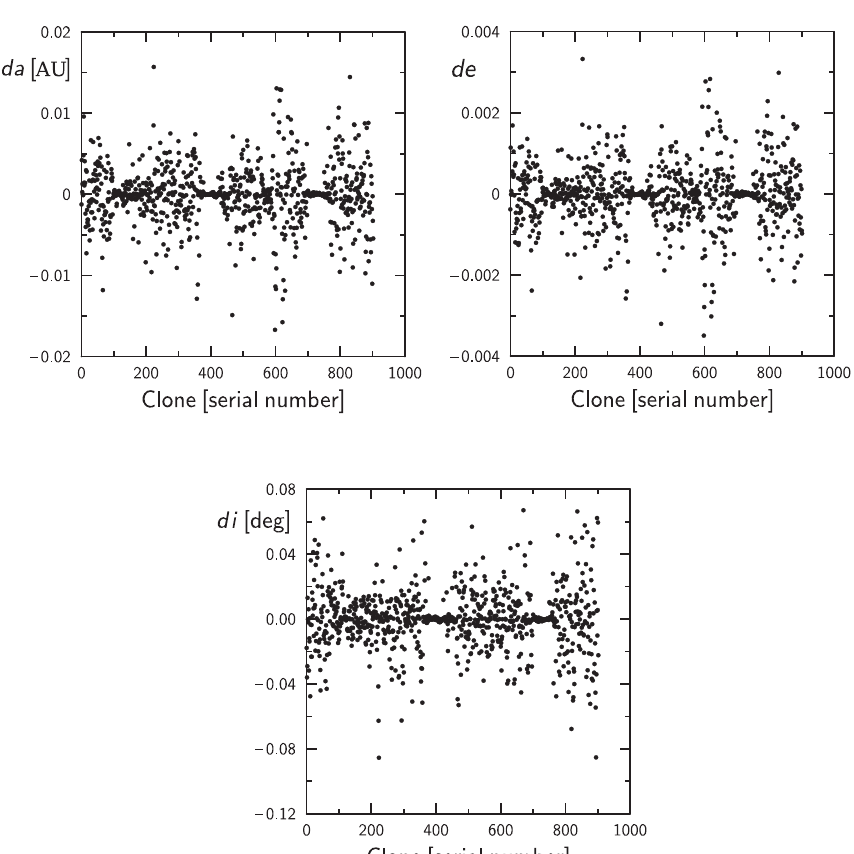
Fig. 3. The asteroid 2008 OS9. Differences in semi-major axis, eccentricity and incli- nation of the asteroid clones in orbits computed with and without the Yarkovsky/YORP effects during the next